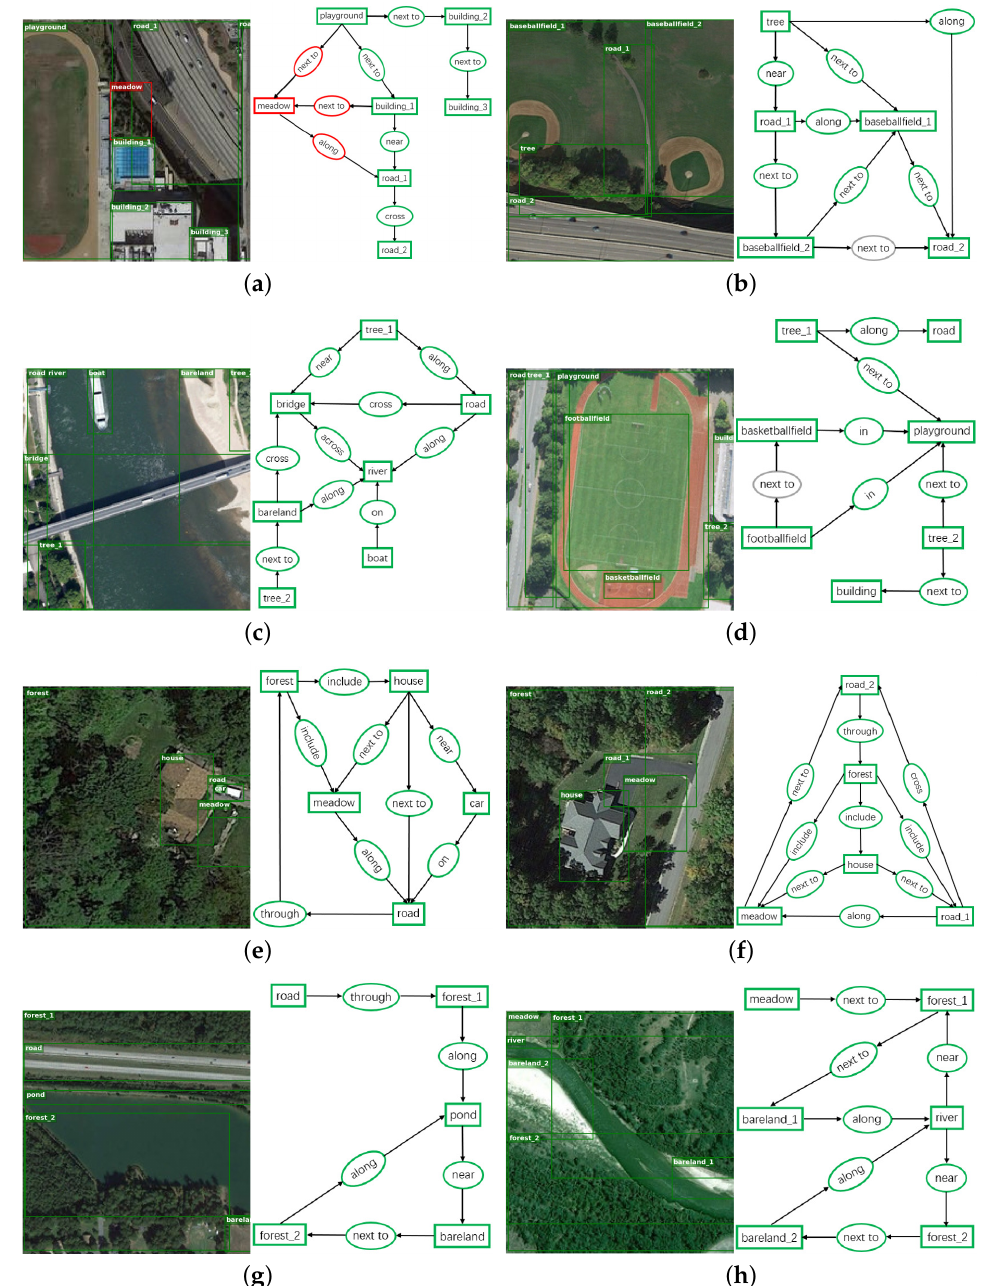
Figure 11. The qualitative examples based on RSSGD. From ( a – h ) are the experimental results of object detection ( left ) and scene graph generation ( right ). In object detection, green boxes are the predicted nodes that matching with ground-truth labels, and red boxes denote the incorrect predictions. In relation reasoning, green ellipse is true positive predicted by our model, grey ellipse is false negative, and red ellipse is false positive. In order to keep the visualization interpretable, we only show the relationship predictions for the pairs of nodes that have ground-truth